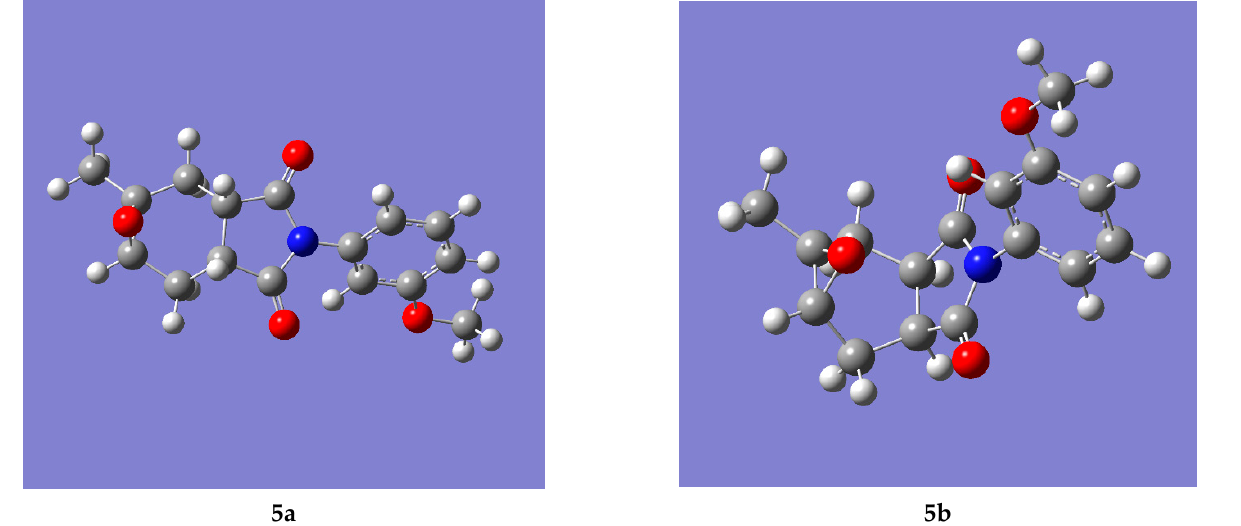
Figure 8. The most stable conformers of epoxides 5a and 5b optimized at M06-2X+G(d,p).